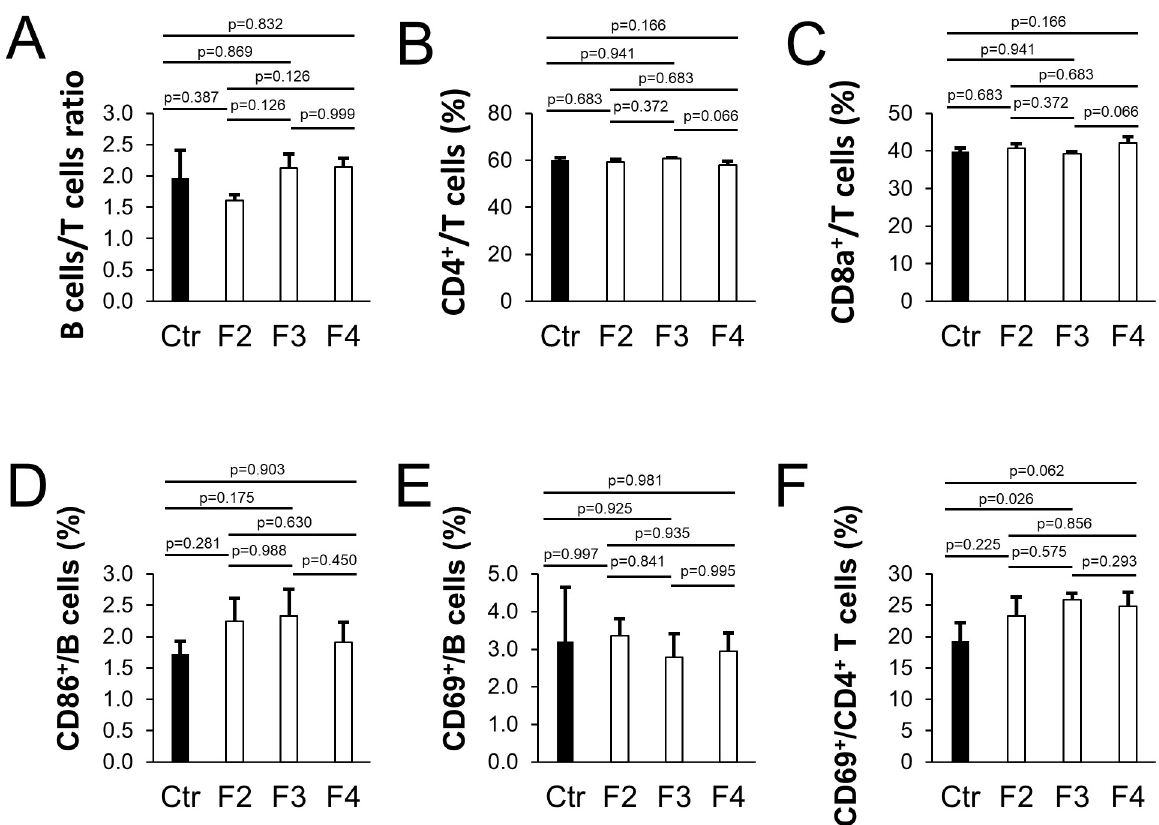
Fig 1. Intergenerational effects of T . halophilus No. 1 on lymphocytes in spleen. We examined the proportion of B cells and T cells in the spleen of mice. Mice (n = 4) were fed diets with or without 1% T . halophilus No. 1 until 16 weeks of age. Then, the spleen samples were obtained and analyzed using flow cytometry. Flow cytometry plots are shown in S2 Fig. For the control, the F2 mice fed control diet were used. (A) The ratio of B cells (B220 + ) and total T cells (CD4 + T cells and CD8a + T cells in total). (B) The proportion of CD4 + among total T cells. (C) The proportion of CD8a + among total T cells. (D) The proportion of CD86 + among B cells. (E) The proportion of CD69 + among B cells. (F) The proportion of CD69 + among CD4 + T cells. Bars indicate the mean ± SD. Based on the Tukey–Kramer test, P-value was found to be relative to the